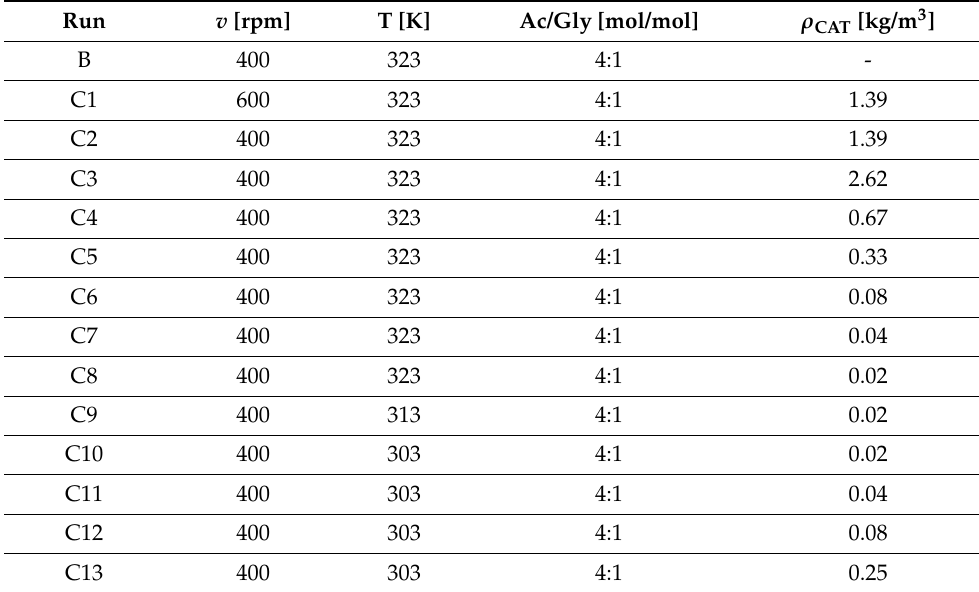
Table 1. Operation conditions for both blank (B) and catalyzed (C) kinetic experiments.